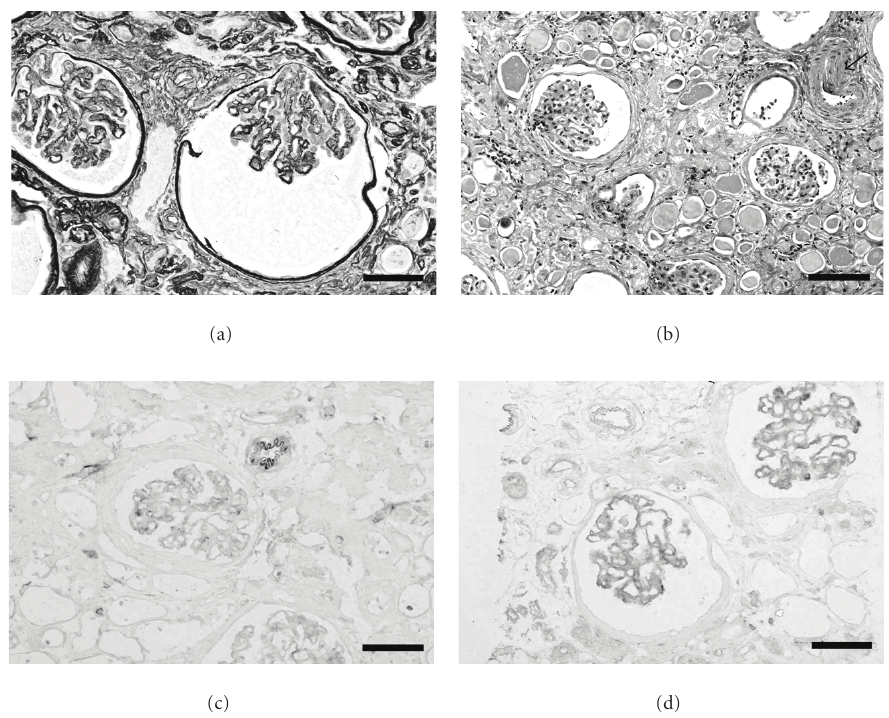
Figure 1: Light micrographs in renal biopsy analysis. (a) Periodic acid methenamine-silver stain; collapse of glomerular tufts, wrinkling of glomerular basement membrane (GBM), and thickening of Bowman’s capsule are observed. (b) Masson’s trichrome stain; severe interstitial fibrosis is observed. Most of the tubular epithelia are flattened, and their lumens are filled with casts. Hyaline degeneration, luminal narrowing, and thickening of the tunica media are seen in a small artery (arrow). (c) IgM detection; granular positive-signals are observed in the capillary wall and mesangial area in the glomeruli. Internal elastic membrane of the small artery shows a positive reaction. (d) Complement C3 detection; linear positive signals are observed in the glomeruli. Bars; 50 (a, c, and d) and 100 (b) µ